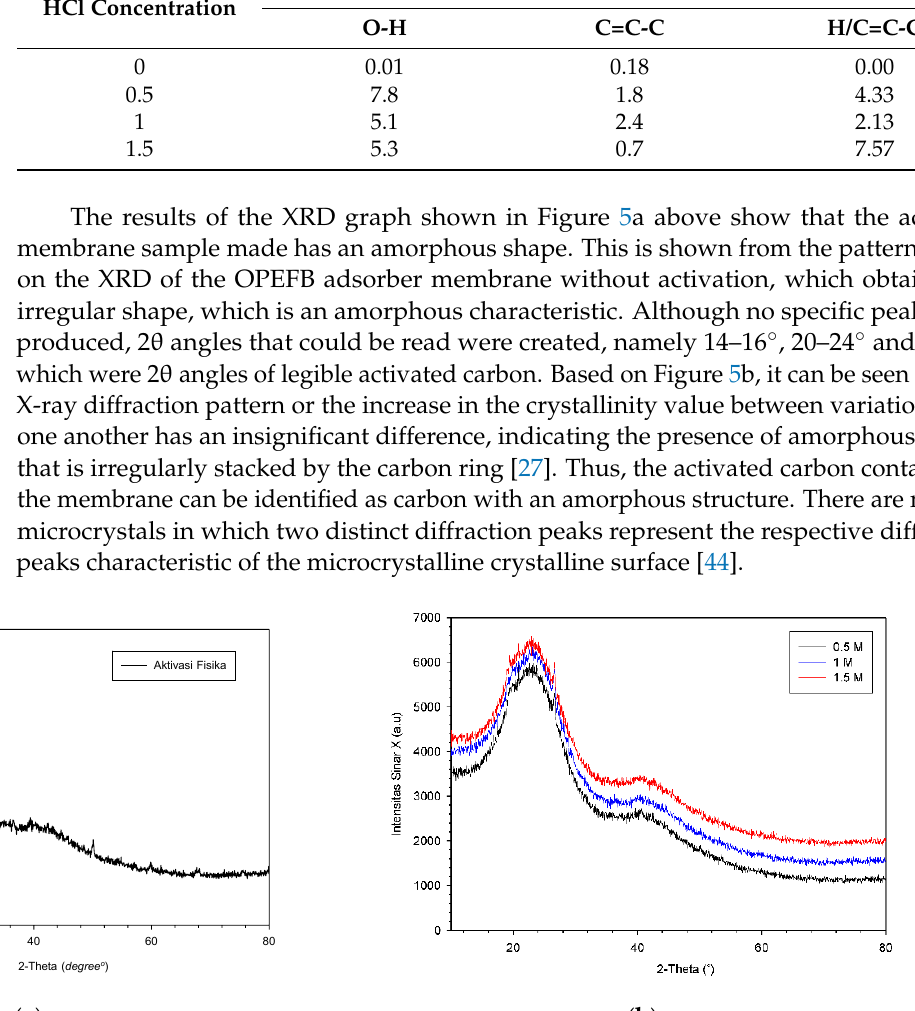
( d ) Figure 6. SEM morphology of: ( a ) unmodified membrane adsorber without HCL activation (AC); ( b ) activated membrane adsorber using g 0.5 M; ( c ) 1 M; ( d ) 1.5 M HCl.